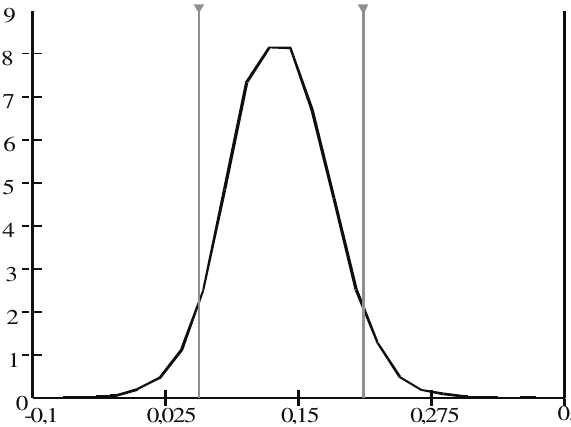
Fig. 4. The density function of internal rate of return in case of apple growing investment